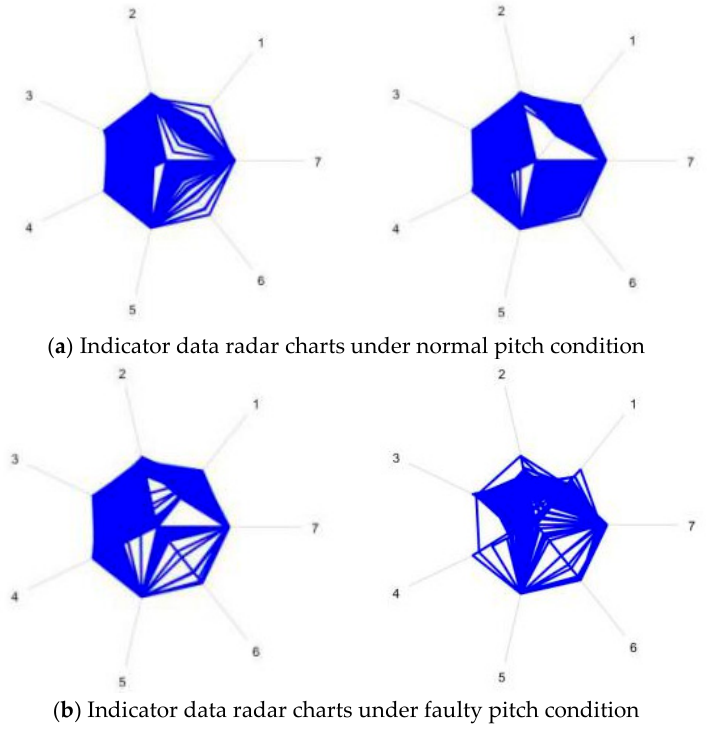
Figure 1. Indicator data radar charts.